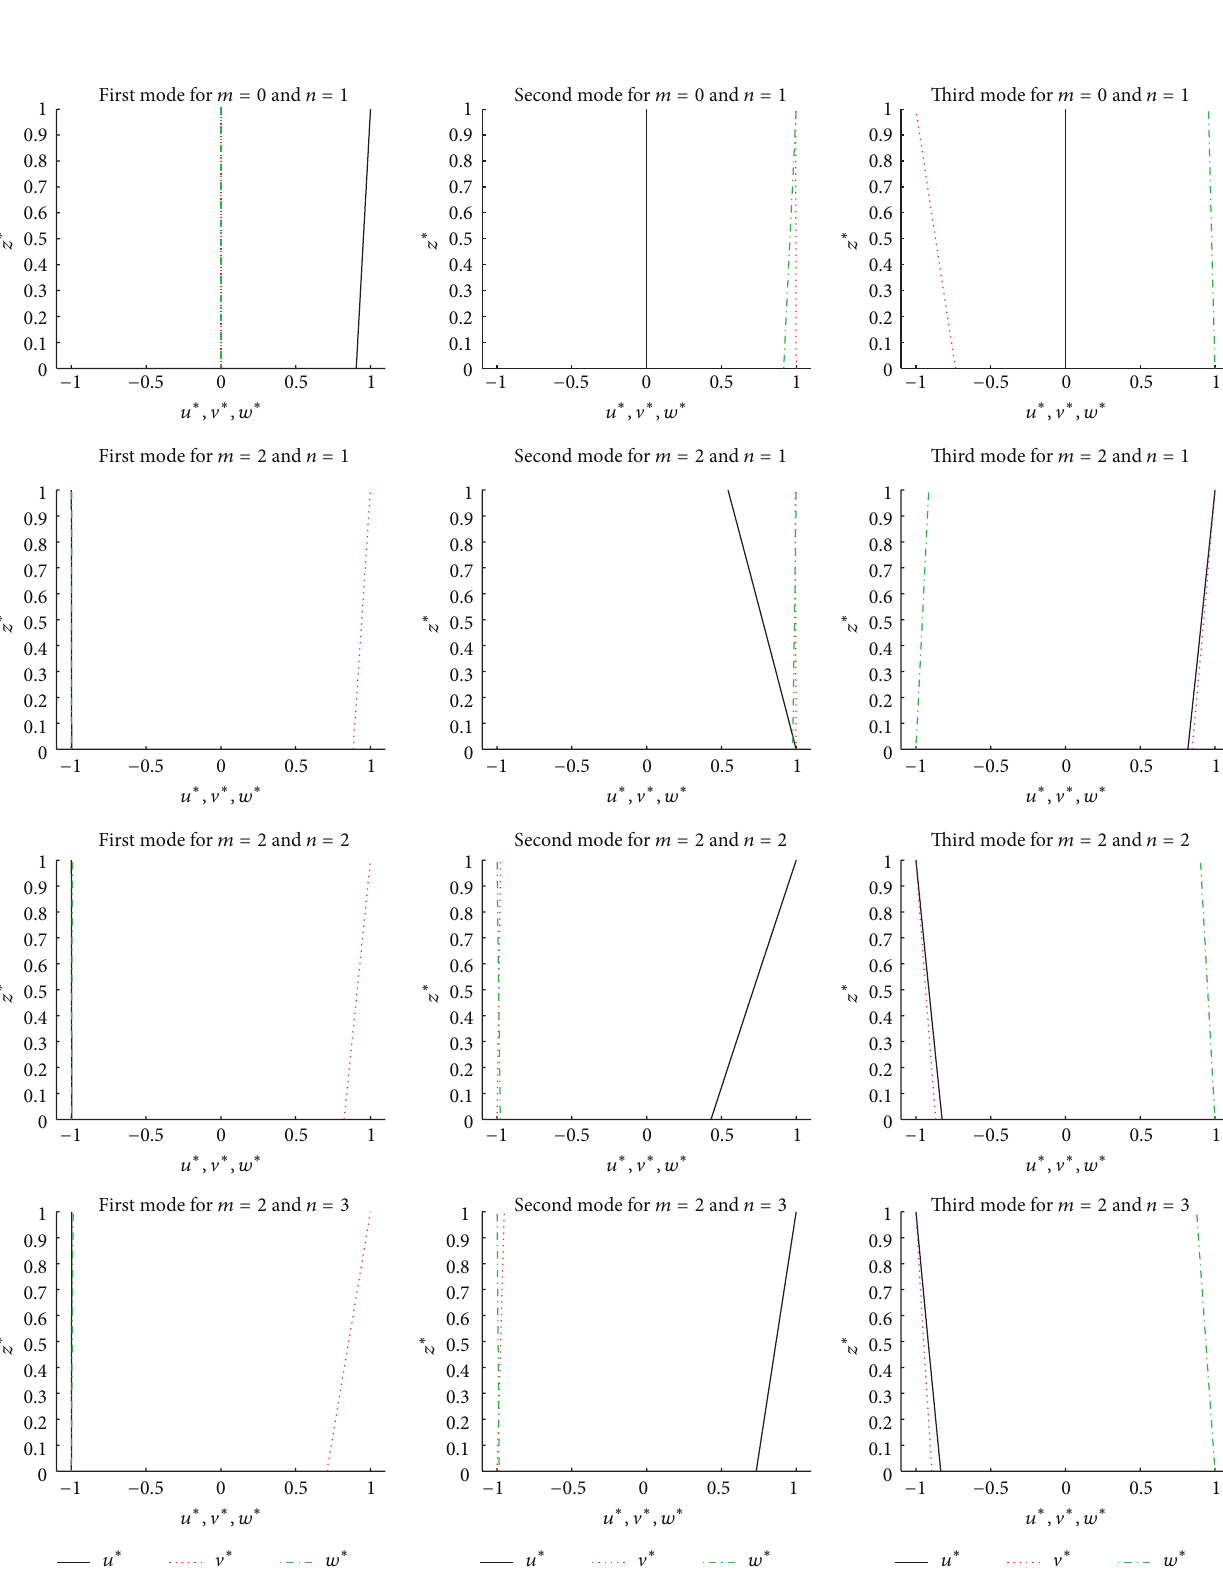
Figure 7: Benchmark 7, simply supported isotropic cylinder. First three vibration modes in terms of displacement components through the thickness for thickness ratio 𝑅 𝛼 /ℎ = 10 and several combinations of half-wave